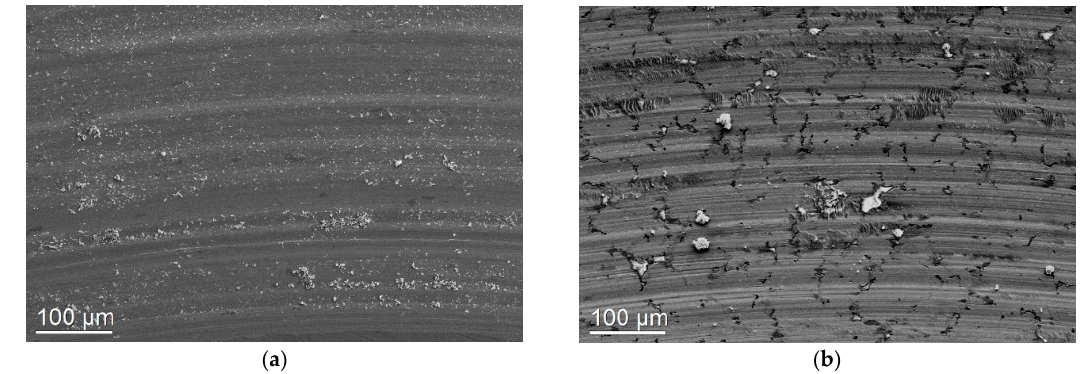
Figure 11. The friction coefficient during ball-on-disk wear testing.